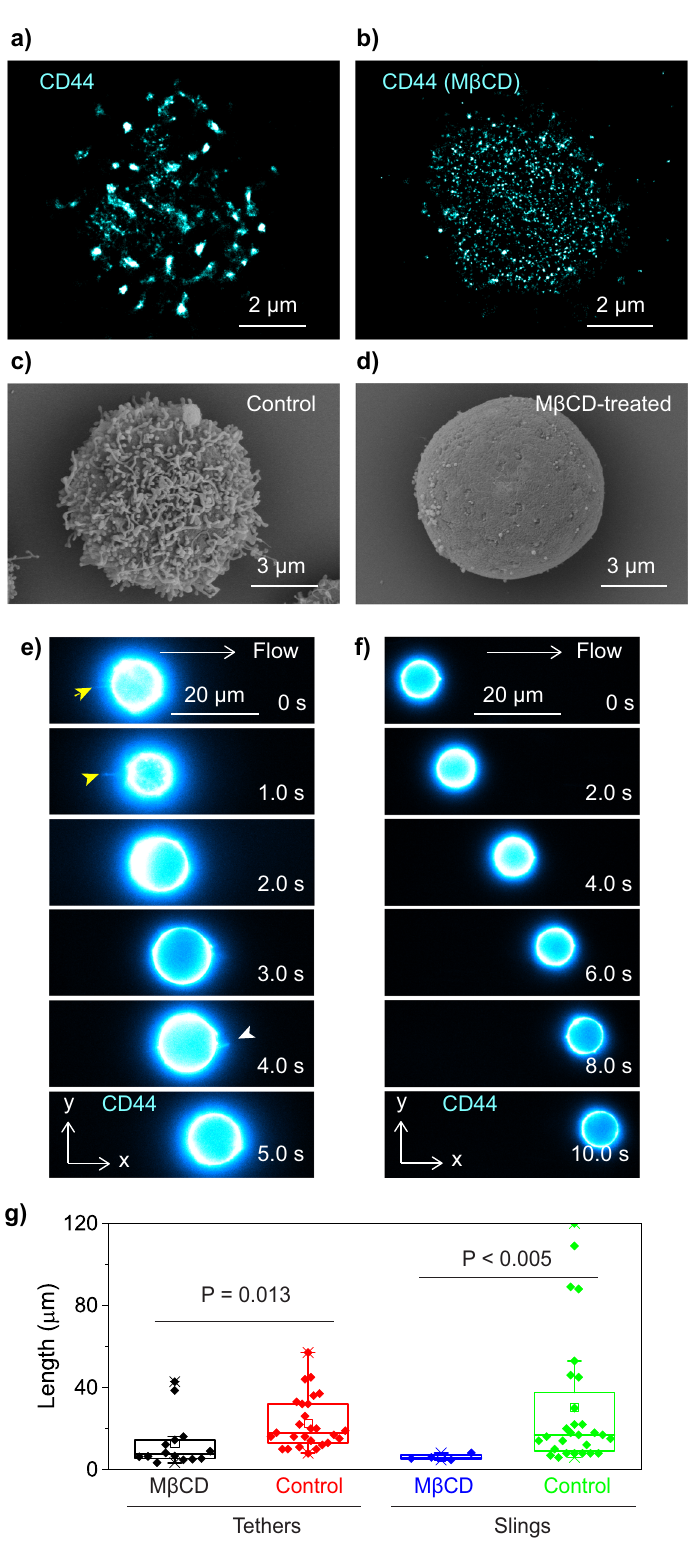
Fig. 5 Effect of microvilli on the formation of the tethers and slings. a , b Super-resolution fl uorescence localization microscopy image of CD44 (immunostained by anti-CD44 515 antibodies followed by Alexa-Fluor-647-conjugated secondary antibodies) on the ( a ) control KG1a cell and ( b ) methyl- β - cyclodextrin (M β CD)-treated KG1a cell. c , d Scanning electron microscopy image of the ( c ) control KG1a cell and ( d ) M β CD-treated KG1a cells. e , f Time-lapse fl uorescence images of the CD44 molecules (immunostained by Alexa-Fluor-647-conjugated anti-CD44 antibody) captured during the ( e ) M β CD-treated KG1a cell and ( f ) CD34 knockdown (CD34-KD) KG1a cell rolling over E-selectin. The yellow and white arrowheads highlight tether and sling, respectively. g Box plots showing the length of individual tethers and slings on the control and M β CD-treated KG1a cells. All the fl uorescence images of the rolling cells were captured by injecting KG1a cells into the rh E-selectin-deposited micro fl uidic chambers at a shear stress of 2 dyne cm − 2